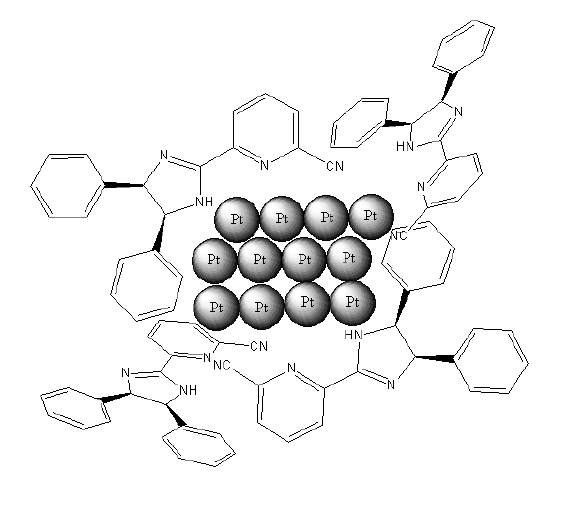
Figure 6. Interaction diagram Pt with ( R,S )-4,5-dihydro-4,5-diphenyl-2-(6-cyano- pyridyl)imidazole in the stabilization of metal